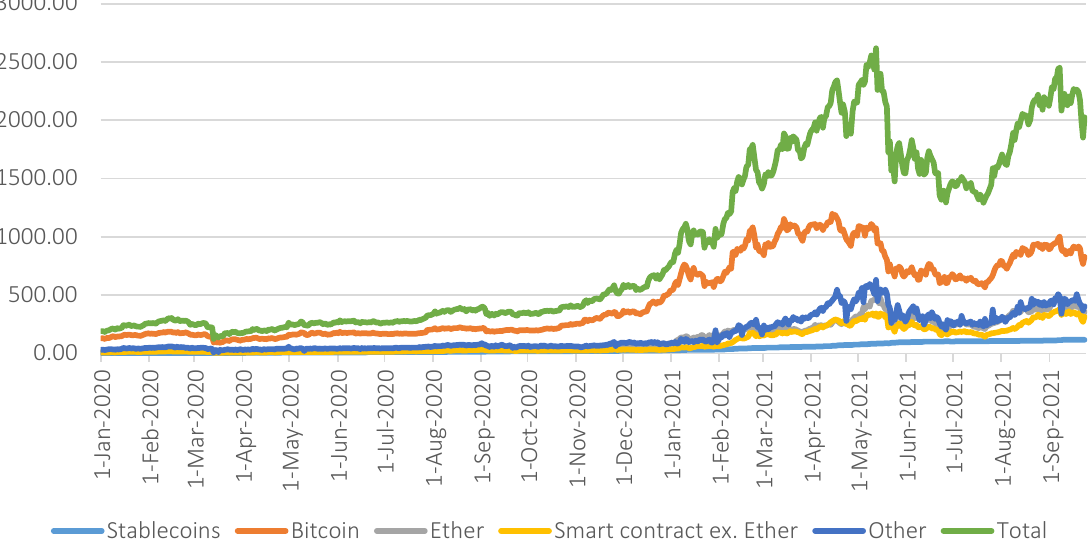
Figure 1. Market capitalization for cryptoassets, USD bln